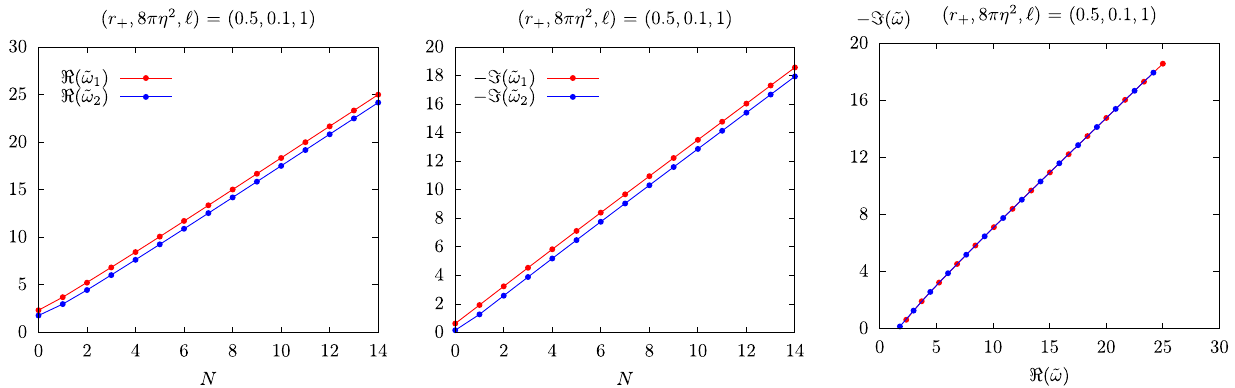
Fig. 5 Theimpactoftheovertonenumber N onthereal(left)andimag- inary (middle) parts of quasinormal modes for the first (red) and second (blue) boundary conditions, with fixed r + = 0 . 5, 8 πη 2 = 0 . 1 and (cid:2)